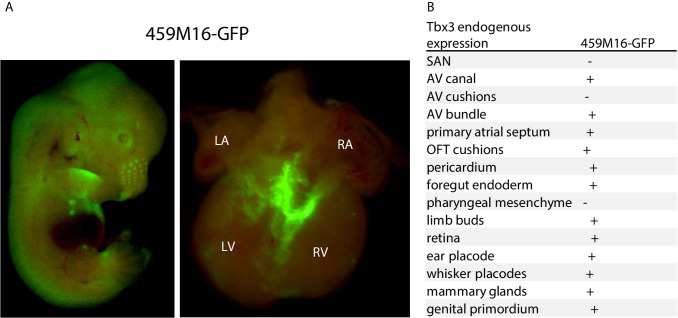
BAC 459M16-GFP recapitulates AVCS expression.(A) Fluorescence of GFP in whole E14.5 459M16-GFP embryo (left) and isolated heart (right). Expression is seen in among others the whisker placodes, limb buds, mammary glands and developing retina. Within the heart, GFP expression is observed in the atrioventricular canal, the atrioventricular bundle and the bundle branches. (B) Table listing regions where Tbx3 is endogenously expressed and where GFP expression in 459M16-GFP E14.5 embryos is (+) or is not (-) observed.